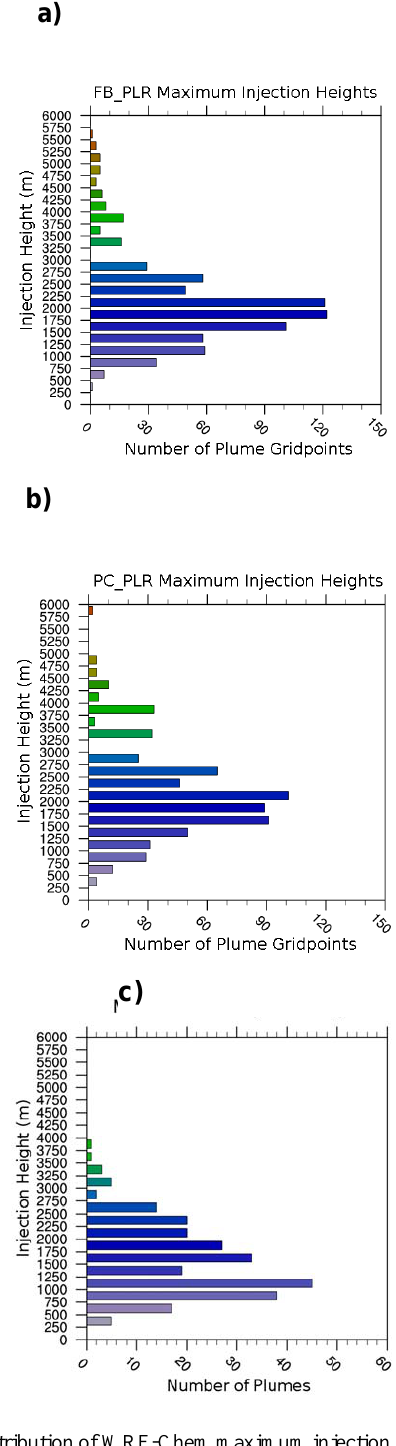
Fig. 5. Distribution of WRF-Chem maximum injection heights over Siberia and Canada during the entire ten day simulation period for (a) FB PLR and (b) PC PLR biomass burning emissions. (c) MISR stereo height distribution for the same period. Note the difference in scale between (c) and (a–b)